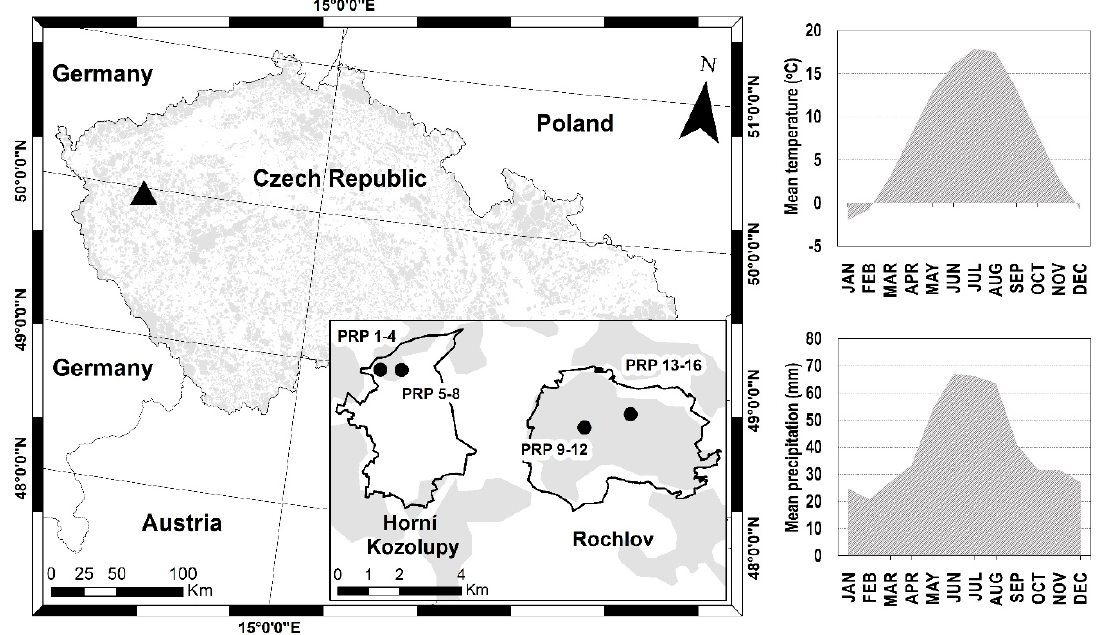
Figure 1. Localization of permanent research plots established in Norway spruce stands in the hunting districts of Horní Kozolupy (LD plots) and Rochlov (HD plots) in the Západo č eská Upland area and monthly climatic characteristics (mean temperature and sum of precipitation between 1961 and 2017). Wider areas of interest are marked by ( ▲ ) symbols. The grey layer in the map symbolizes forest areas in the Czech Republic.